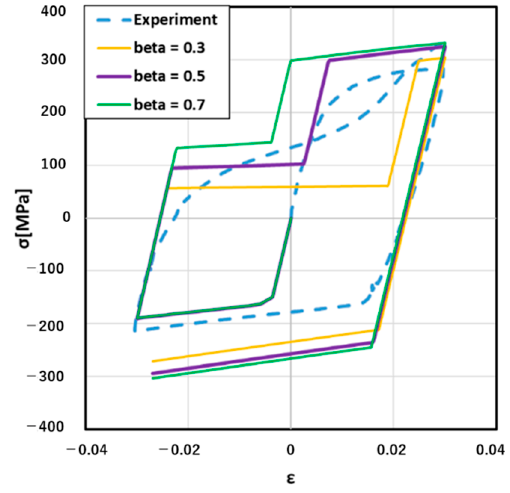
Figure 7. Results with different values for 𝛽 .